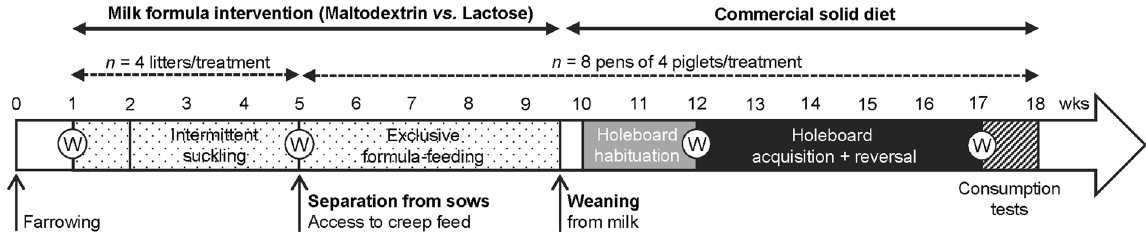
Figure 1. Study timeline. W stands for